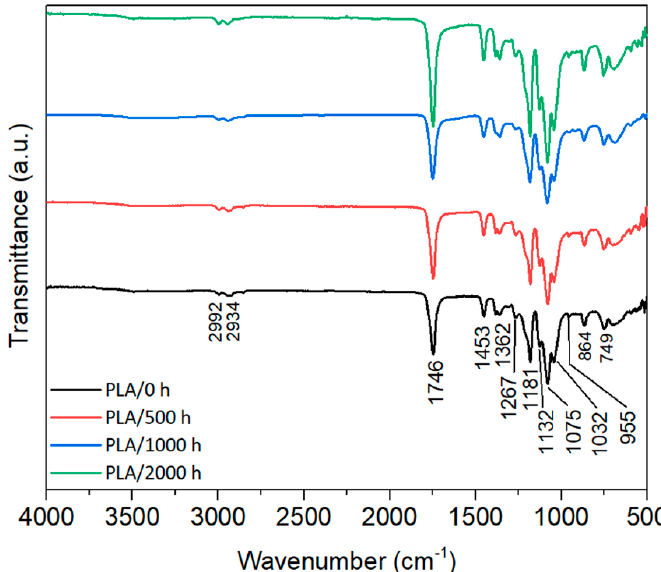
Figure 9. FTIR spectra of neat PLA before (0 h) and after (500, 1000 and 2000 h) accelerated weathering.